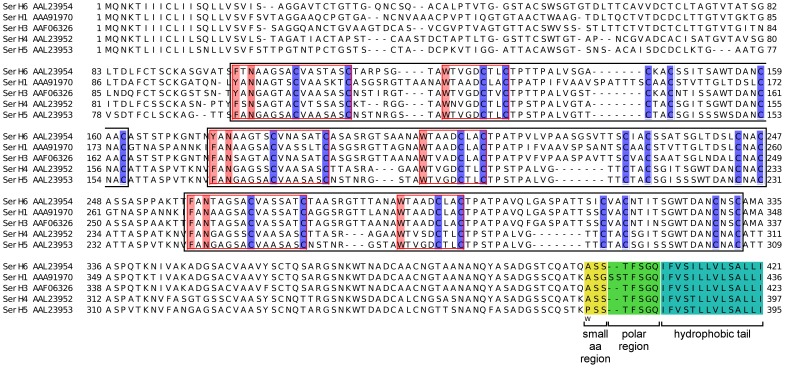
Features of T. thermophila Ser protein sequences.Selected known Ser protein sequences are aligned to show their Cys pair, repetitive block and GPI anchor site. Cys residues are highlighted (dark blue). Each repetitive block is indicated by black box. Red box indicates sequence feature which appears in each repetitive block. The region predicted as GPI anchor signal by FragAnchor is color-shaded. Predicted GPI attachment site is marked by letter “w”. According to data from known Ser, number of Cys residues per repetitive block is unique for each subtype (SerL: 6 Cys per block; SerH: 8 Cys per block). The length of each repetitive block differs among various subtypes and is also varied between 55–100 aa. GPI anchor signal predicted by FragAnchor exhibits region of small amino acids (Ala, Gly, Ser) where GPI is attached (yellow), followed by polar region (green) and hydrophobic tail (light blue).